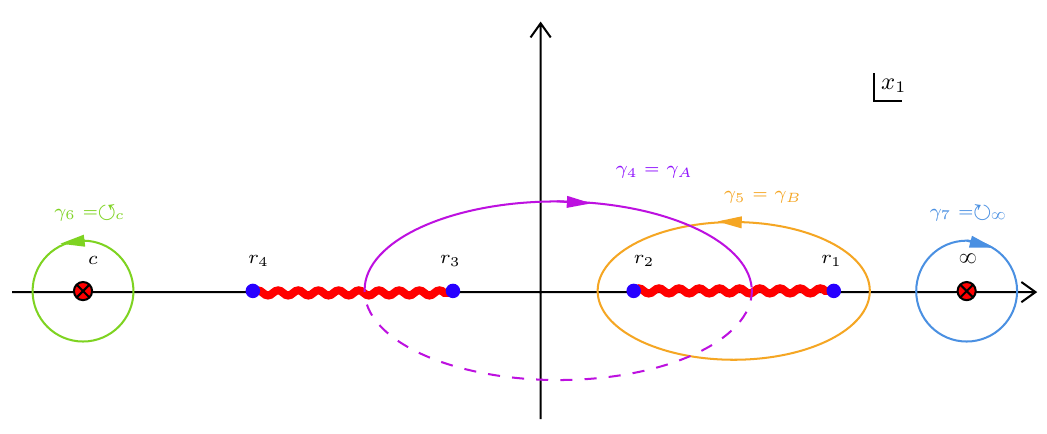
4 ( ε 0 ). Following standard conventions, the residue Figure 3 . The homology basis in D “ “ contour at finite point is oriented counterclockwise, while the residue contour at infinity is oriented clockwise. The orientations of the non-algebraic A - and B -cycles are such that the intersection q γ q γ number 1 5 | 4 s “ ` r